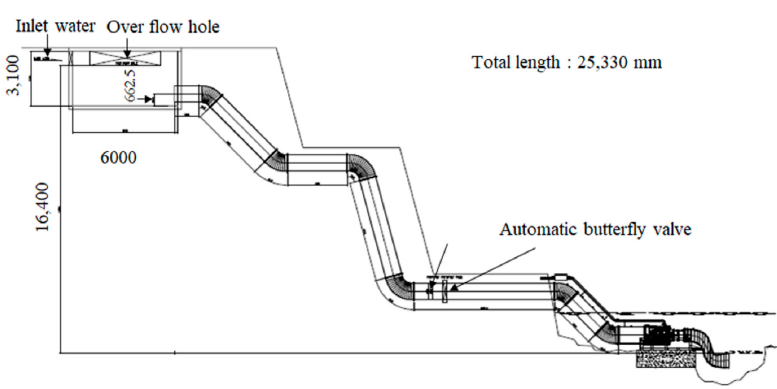
Figure 4. Schematic installation diagram of an offshore small hydropower plant.